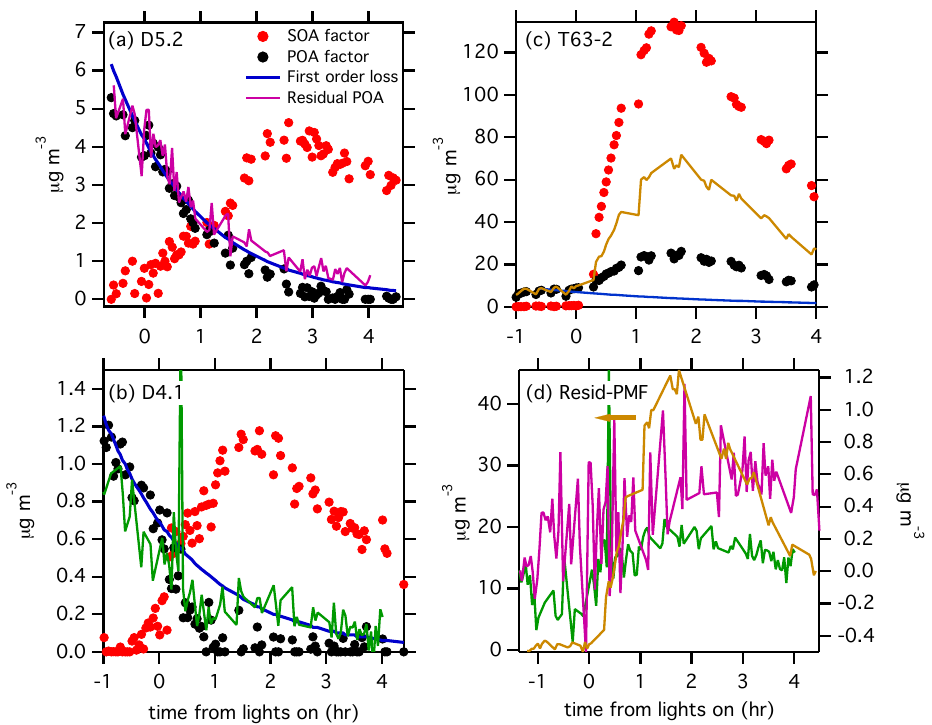
Figure 3. (a)–(c) Comparisons of PMF-derived POA (black symbols) and SOA (red symbols) concentrations to assumed first-order POA loss (blue line) and the POA concentration determined by the residual method. POA determined by the residual method is color-coded: purple for experiment D5.2 (a) , green for D4.1 (b) , and brown for T63-2 (c) . The SOA concentration in (c) is the sum of SOA 1 and SOA 2. The difference between POA concentrations determined by the residual method and PMF is shown in (d) . The residual method consistently overpredicts POA concentrations relative to